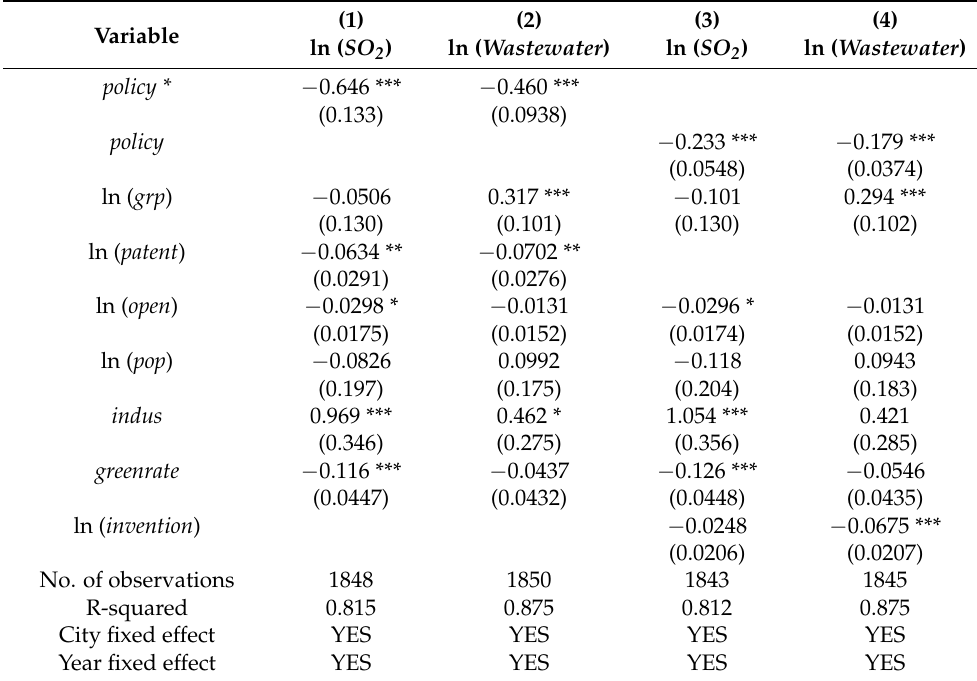
Table 5. Robustness checks—variable